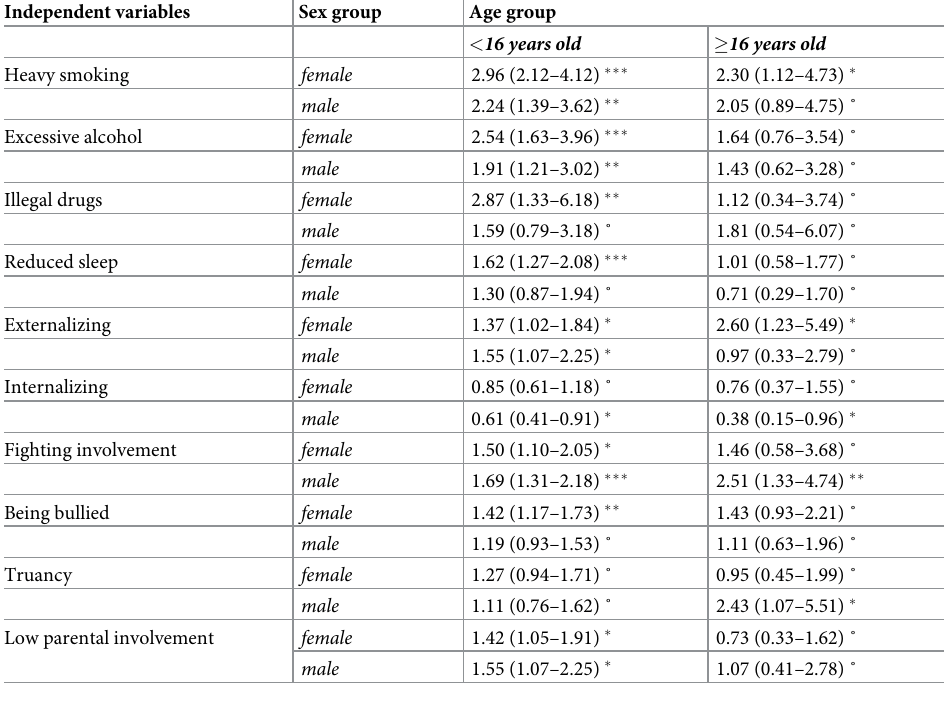
Table 3. Predictors of sexual initiation during 12 month follow-up in European adolescents: Age and sex stratified analysis. Independent